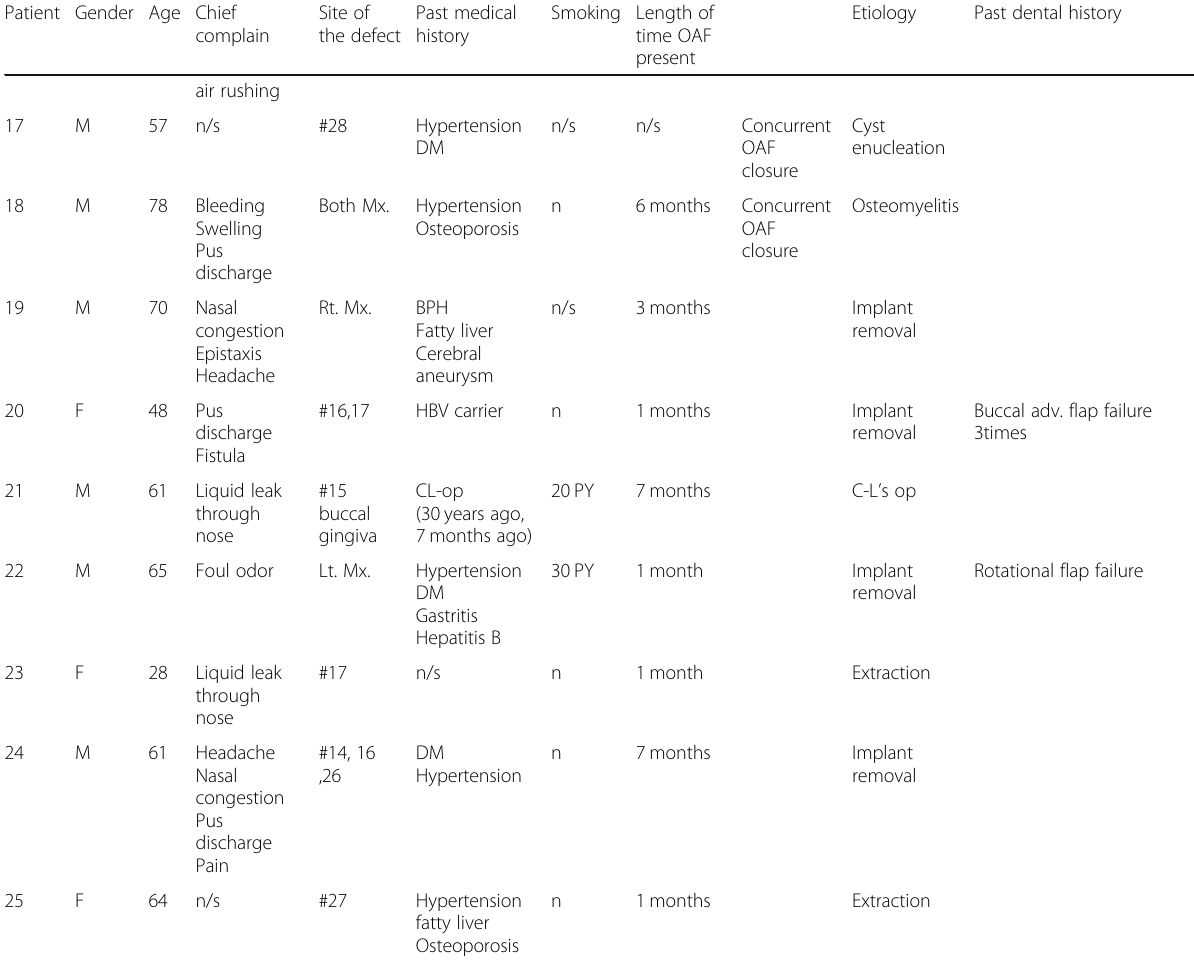
Table 1 Summary of clinical details (Continued)